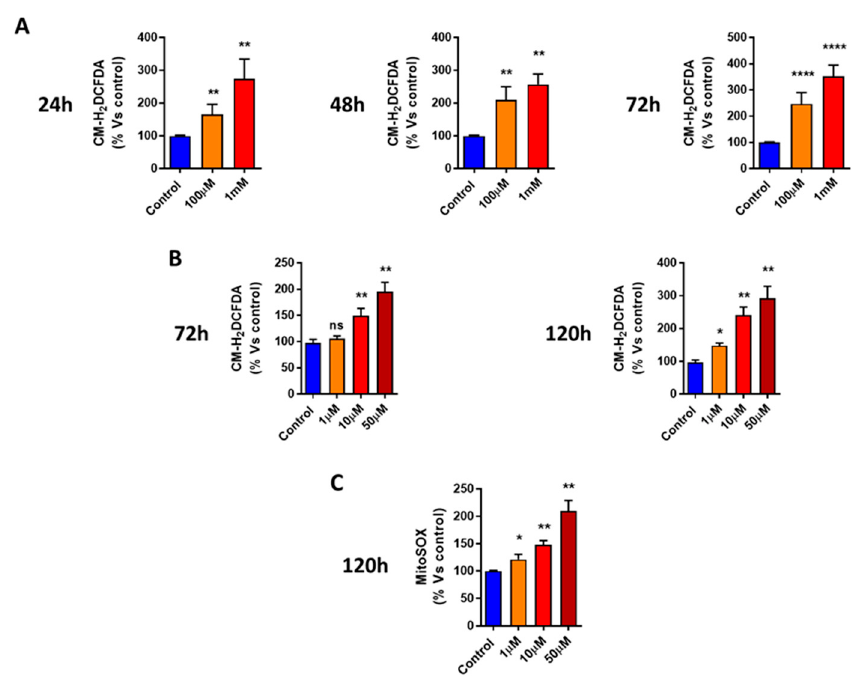
Figure 7. DFP induces total cellular reactive oxygen species (ROS) production in MCF7 cells. ( A ) Note that DFP increases the total cellular ROS production in a time-dependent and concentration-dependent manner (from 24 h to 72 h), with maximal effects observed at 1 mM. ** p < 0.001; **** p < 0.00001. ( B ) DFP treatments at 72 h and 120 h significantly elevate the total cellular ROS production after DFP treatment in the micro-molar range (1 to 50 μ M). ns = not significant; * p < 0.01; ** p < 0.001. ( C ) DFP induces mitochondrial superoxide production in MCF7 cells and significantly elevates mitochondrial superoxide levels after DFP treatment in the micro-molar range (1 to 50 μ M). ns = not significant; * p < 0.01; ** p < 0.001.